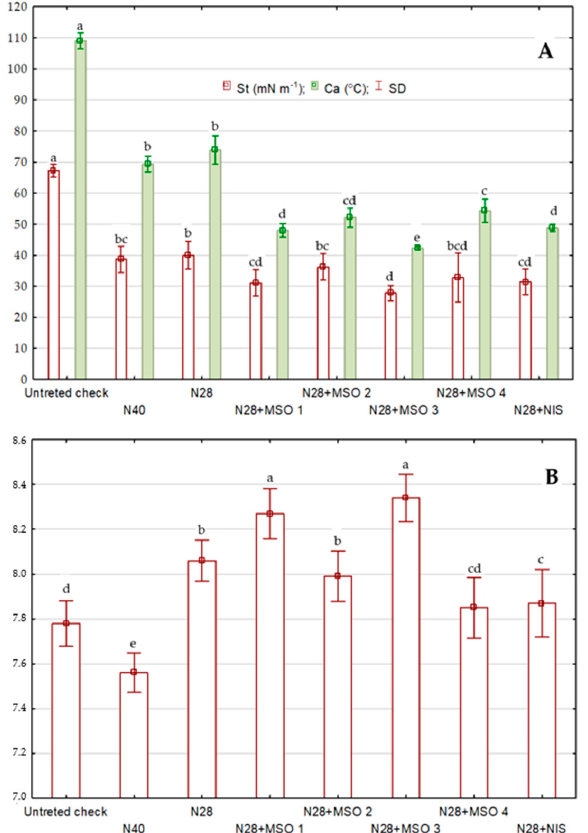
Figure 1. Impact of adjuvants (MSO 1, 2, 3, and 4 and NIS) on surface tension (St), contact angle (Ca) ( A ), and reaction of spray liquid ( B ) with nicosulfuron (N). Means followed by the same letter in the column do not differ according to Tukey’s test at p = 0.05. SD—standard deviation. In 2017, nicosulfuron at recommended and reduced rates effectively controlled only ECHCG (Table 2). WCE (weed control efficacy) of other weeds was mostly lower when